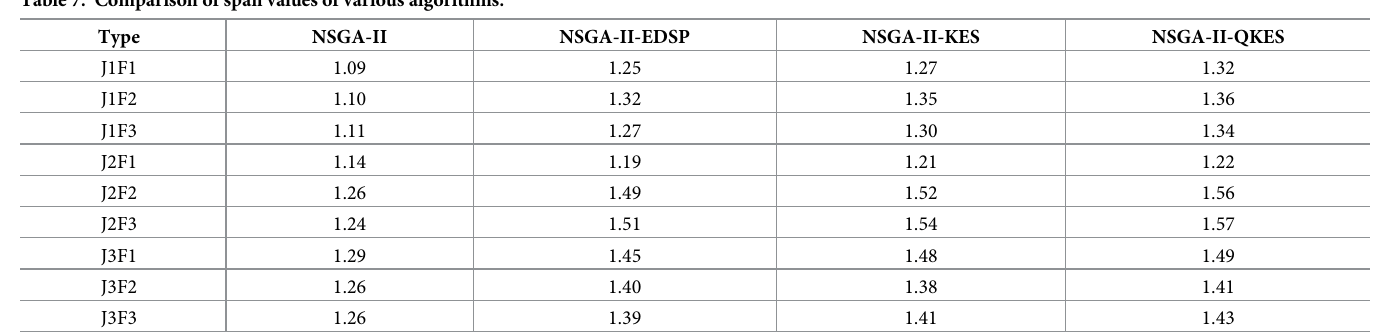
Table 7. Comparison of span values of various algorithms.